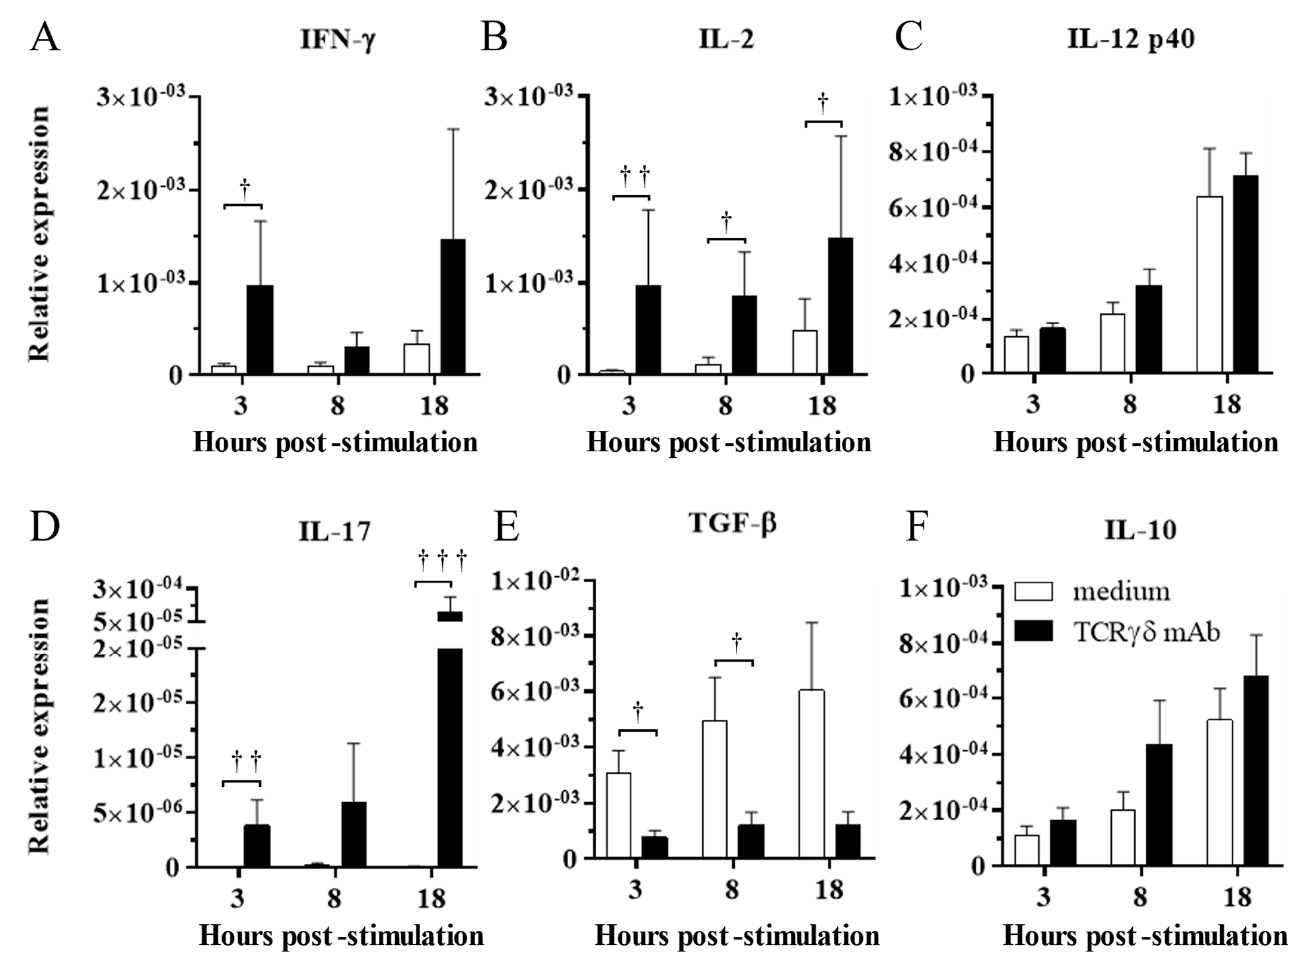
Figure 2. Cytokine expression profiles in the PBMCs stimulated with or without anti-TCR γδ antibody at 3, 8, and 18 hps. The PBMCs obtained from healthy SPF chickens were stimulated with or without anti-TCR γδ antibody for 3, 8, and 18 h, and RNA were extracted from the cultured PBMCs. Expression of cytokines, IFN- γ ( A ), IL-2 ( B ), IL-12p40 ( C ), IL-17A ( D ), TGF- β ( E ), and IL-10 ( F ) was determined by real-time PCR. Target genes were normalized by β -actin. TCR γδ -unstimulated cells were used as a negative control. Data represent the mean of 6 biological replicates ± SE at each time point. Significant differences are indicated by †: p < 0.05, ††: p < 0.01, and †††: p < 0.001.